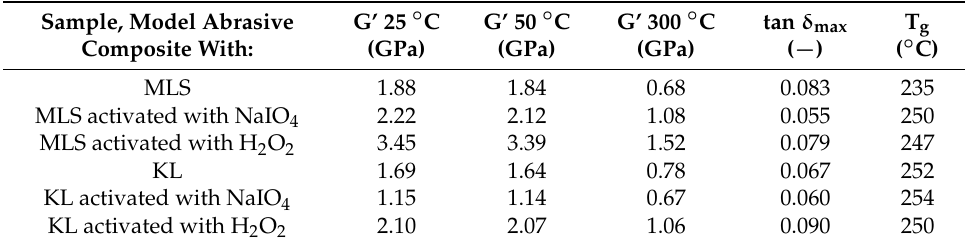
Table 3. Values of storage modulus (G’), highest loss factor (tan δ max ) and glass transition temperature (T g ) for the examined